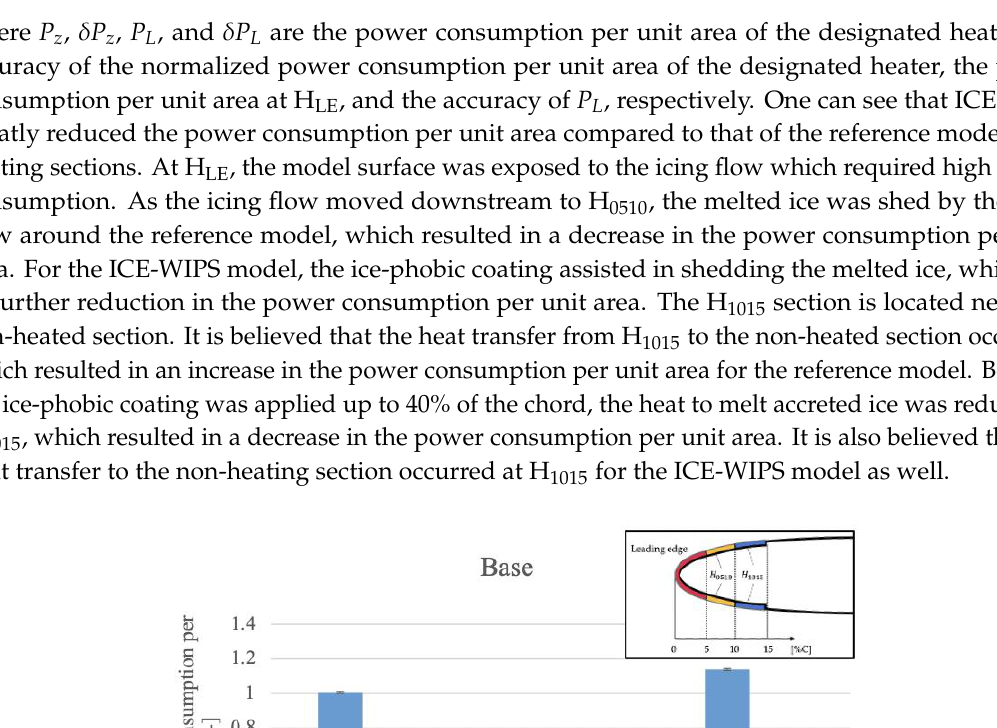
Figure 9. Normalized power consumption per unit area of each heating area for High MVD case.